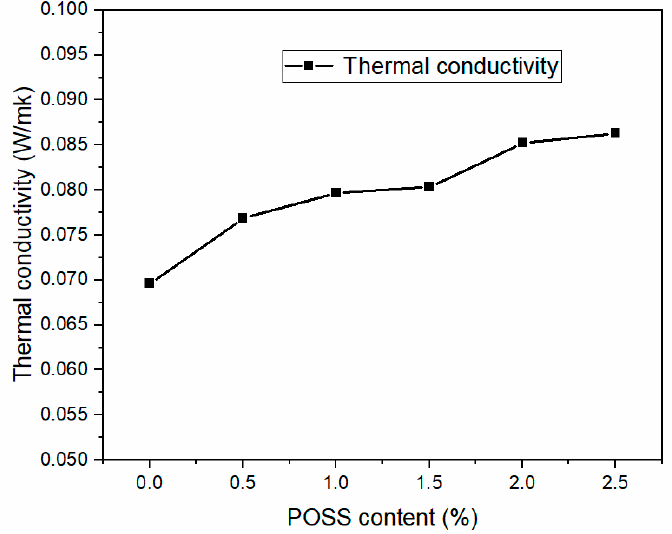
Figure 10. Thermal conductivity of SIFs with di ff erent MAPOSS